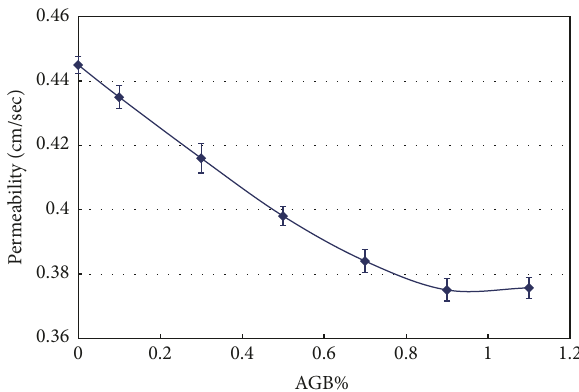
Figure 4: Permeability as a function of AGB